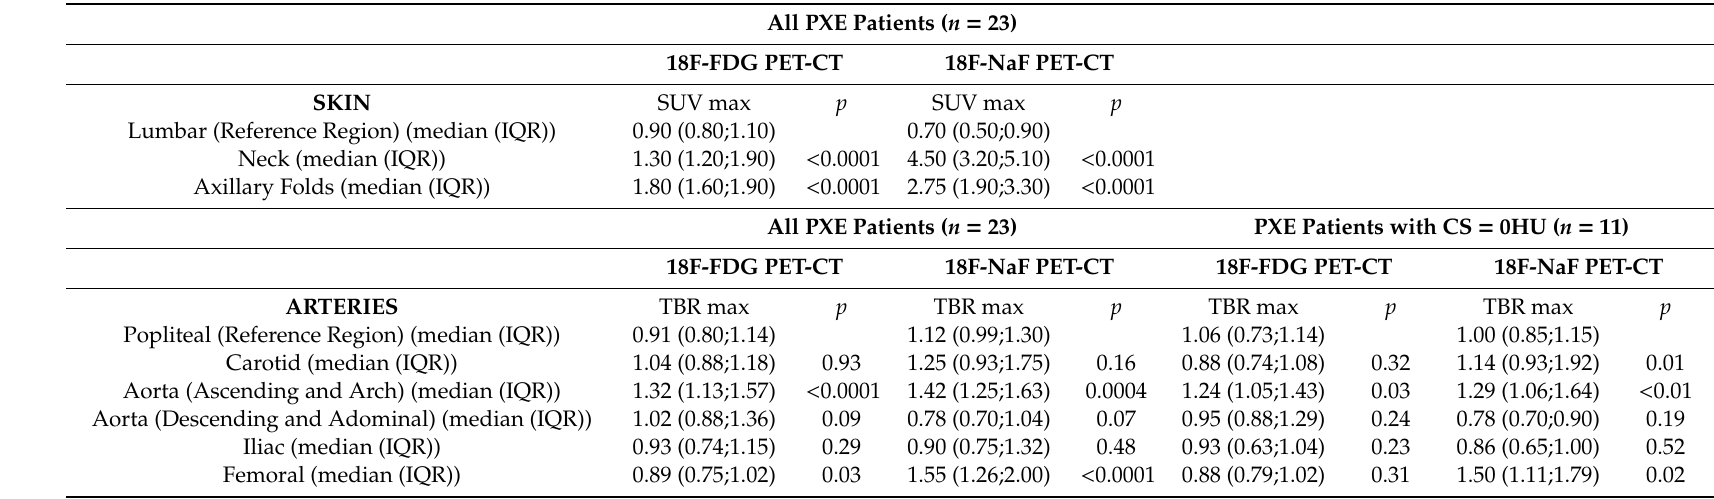
Table 2. Assessment of LGCI using 18F-FDG-PET-CT and ectopic calcification using 18F-NaF-PET-CT. All PXE Patients ( n = 23) 18F-FDG